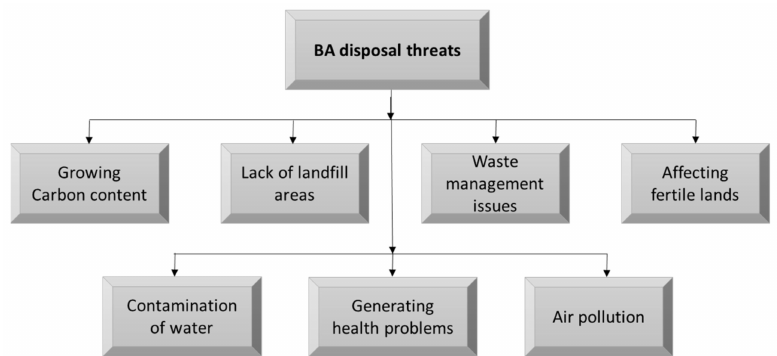
Figure 2. Problems associated with disposal of bagasse